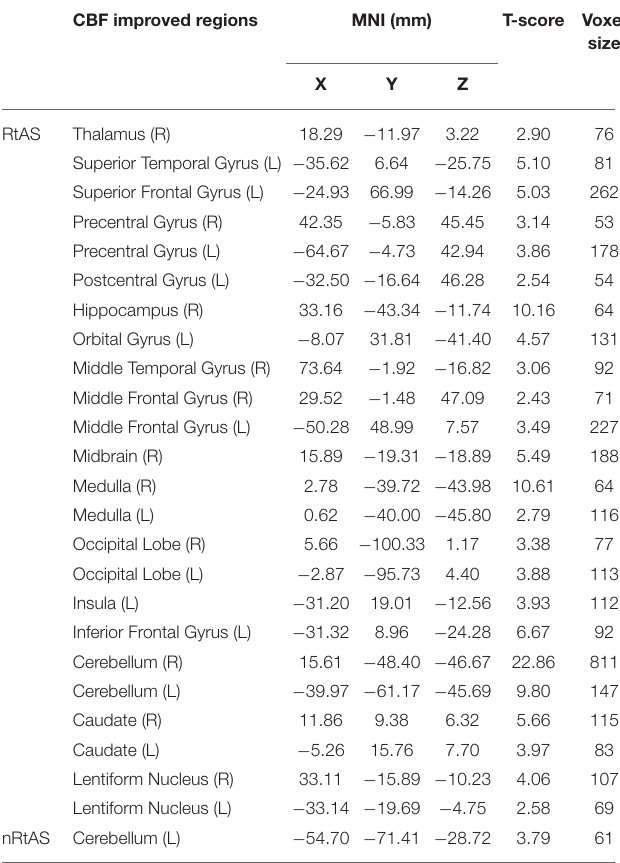
TABLE 2 | CBF increased brain regions by